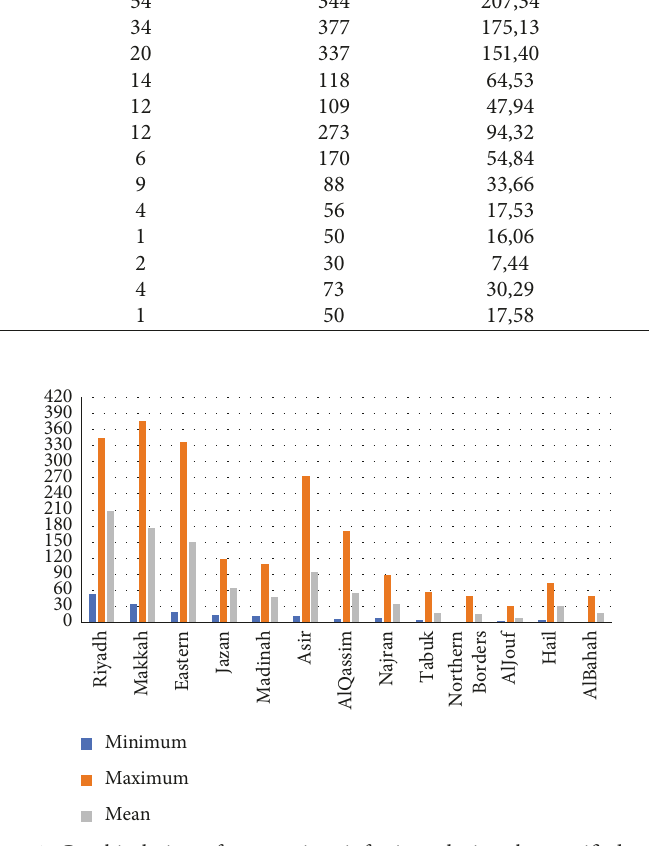
Figure 1: Graphical view of coronavirus infections during the specified period.